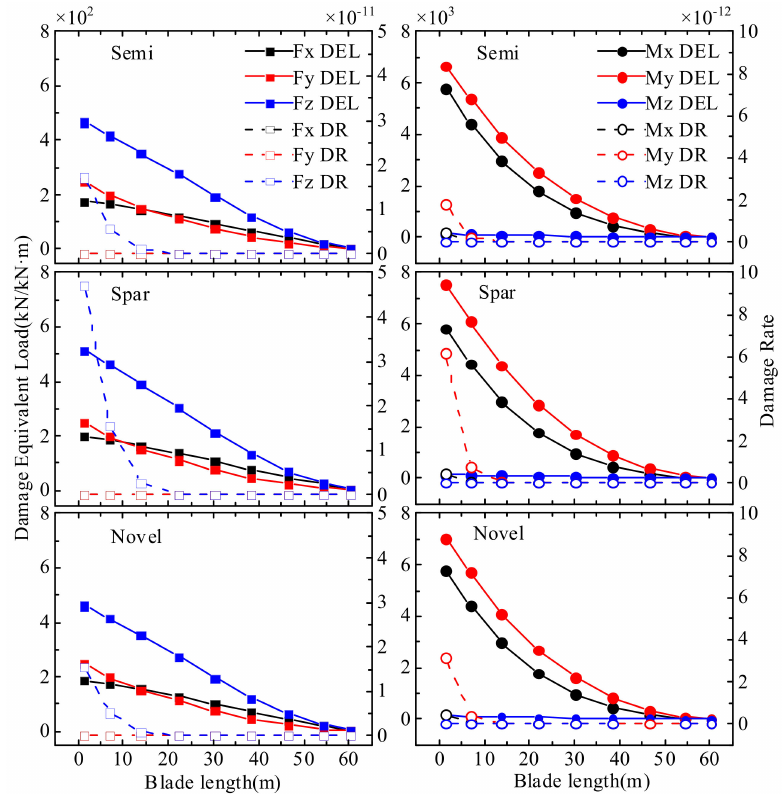
Figure 29. Blade fatigue load of three FOWTs.